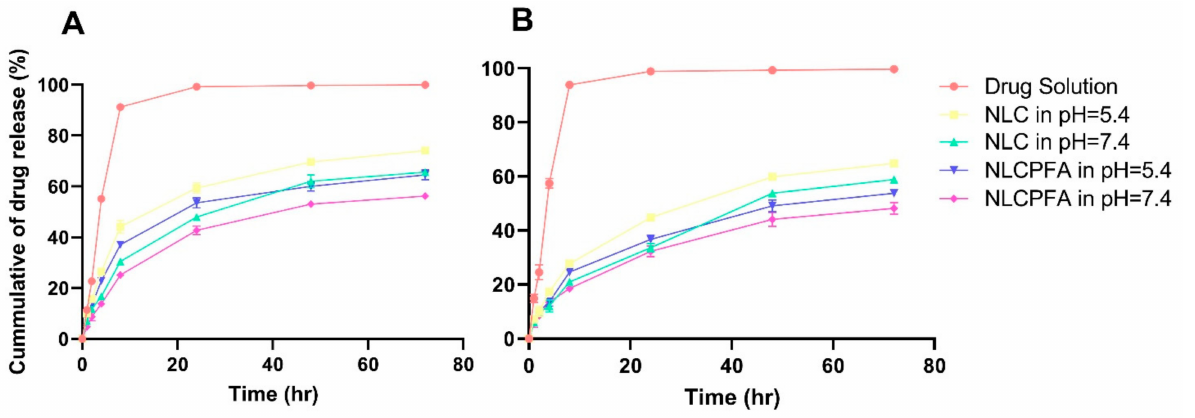
Figure 2. Release curves by experimental data of ( A ) Cyclo and ( B ) Let from different